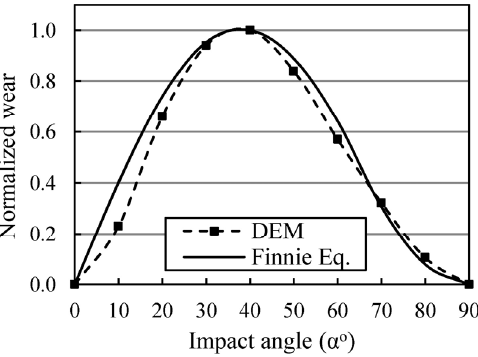
Fig. 4 Dependence of the wear on the impact angle of a single particle, obtained using the DEM and Finnie equation.